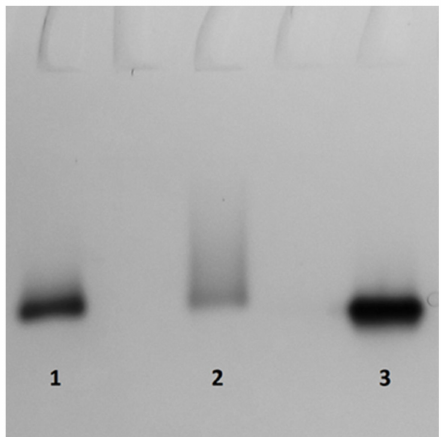
Figure 6. Zymogram of laccase from the culture medium of L. edodes at 28 days of cultivation. The gel was stained with ABTS as substrate of laccase. Lanes: 1—SL cultivation without agitation; 2—SM cultivation with agitation with 2% CS lignin supplement; and 3—SL cultivation without agitation with 2% CS lignin